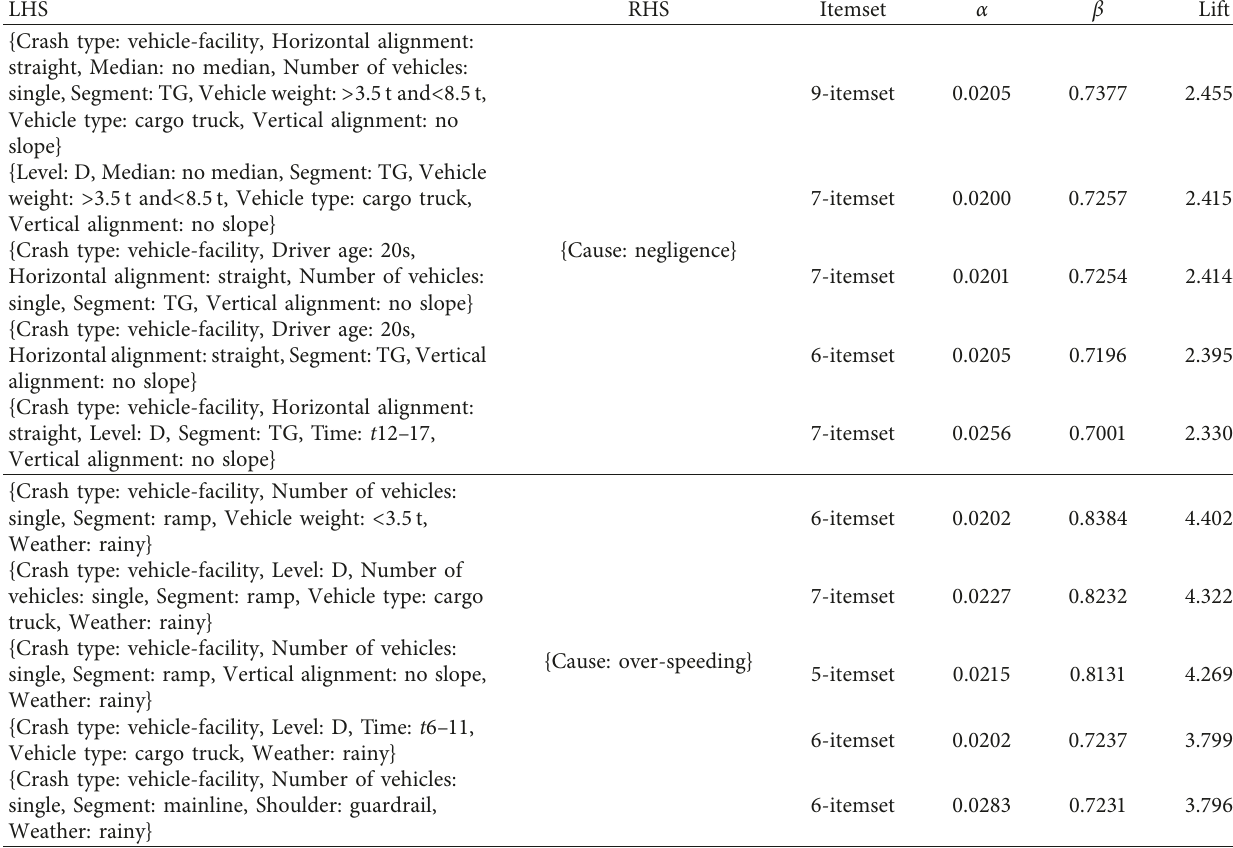
Table 8: Association rules by driver’s